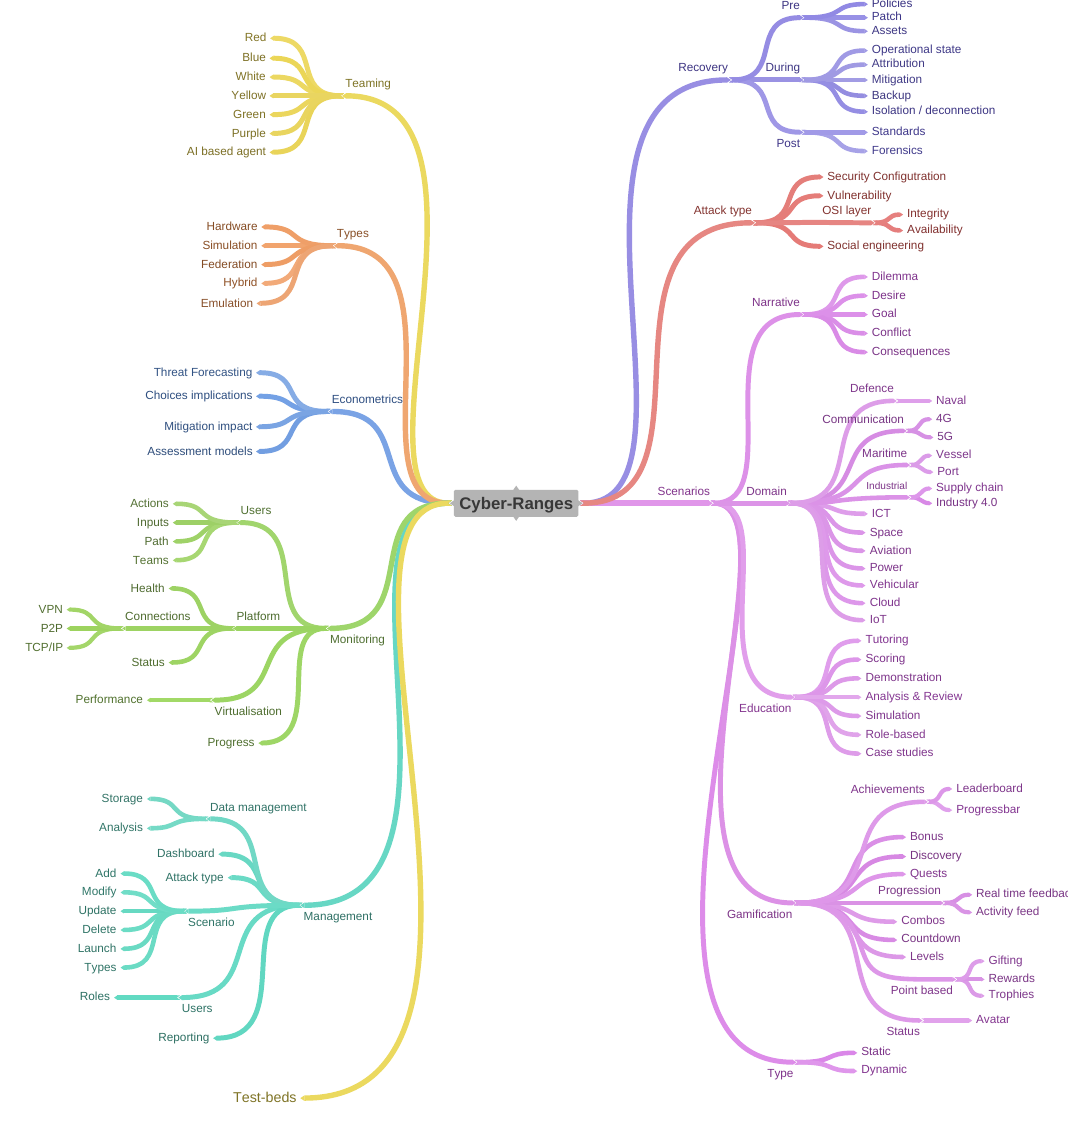
Figure 17. Cyber-Range